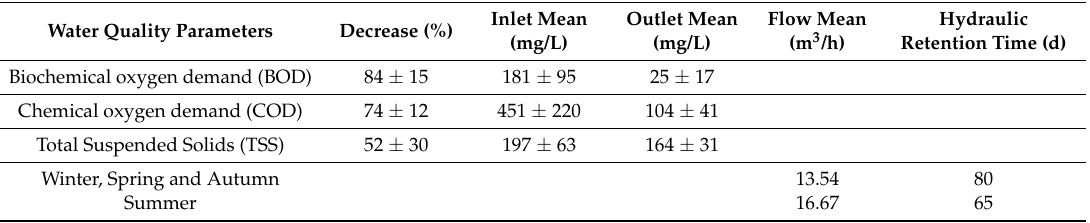
Table 1. Values of different parameters of water quality from the treatment plant EDAR Fuente de Piedra II.